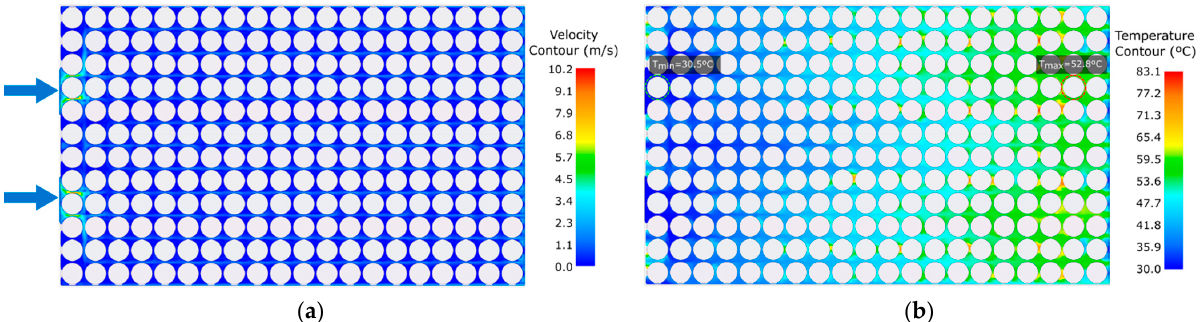
( b ) Figure 5. The contour of ( a ) velocity and ( b ) temperature of 3 inlet model. ( a ) ( b ) Figure 6. The contour of ( a ) velocity and ( b ) temperature of 4 inlet model. The air entered the battery pack through the inlet on the left side and exited through the outlet on the right side while taking the heat generated by the batteries in the process. The arrows on the left side of the figure indicate the number and locations of the inlet and the airflow direction. The air velocity had its maximum value around the inlet as the near- est area to the cooling fan. It gradually decreased as it reached the outlet due to the de- creasing kinetic energy. On the contrary, the battery temperature was at the minimum value around the inlet and gradually increased as it got further. This happened because the convective heat transfer decreased due to the rising temperature of the air as it traveled through the battery pack while taking the heat from the batteries. This phenomenon led to the temperature difference that resulted in different charging/discharging rates be- tween battery cells, causing a heavy workload for BMS. Excessive workload caused inef- ficient equalization, especially for BMS with an active balancing method, leading to non- optimal power generation and reducing the batteries’ lifespan faster. Ideally, the simula- tion result needs to be validated with an experiment, but obtaining velocity and temper- ature contour from an experiment might be challenging. However, the current simulation